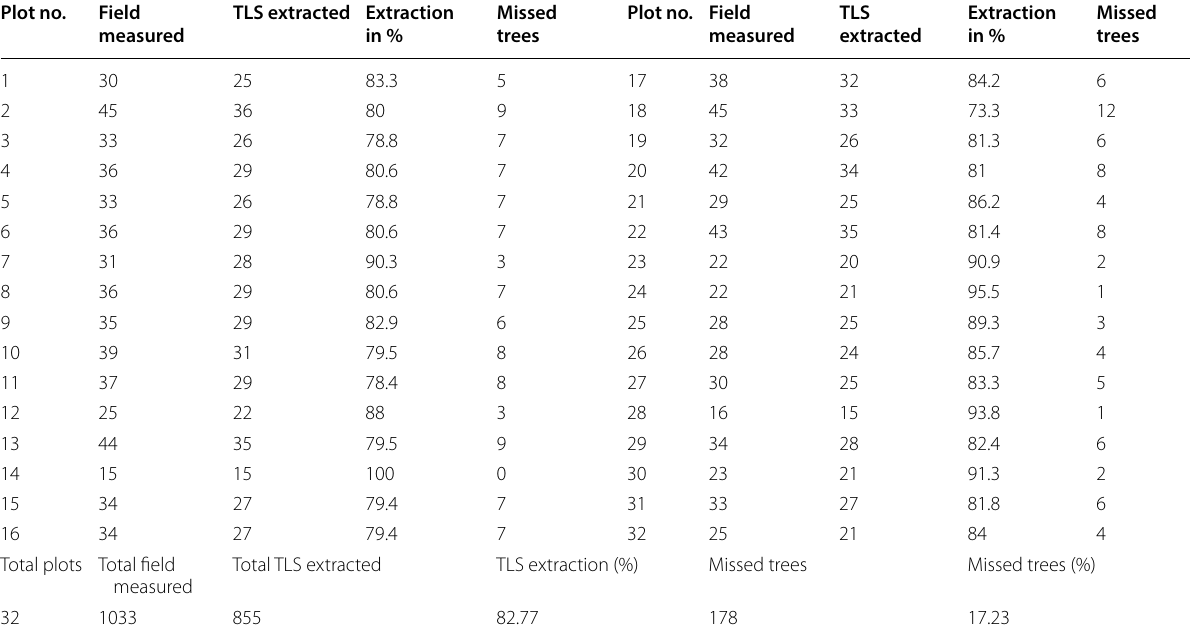
Table 2 Number of trees measured in the field and extracted from TLS Plot no. Field TLS extracted Extraction Missed Plot no. Field measured in % trees measured